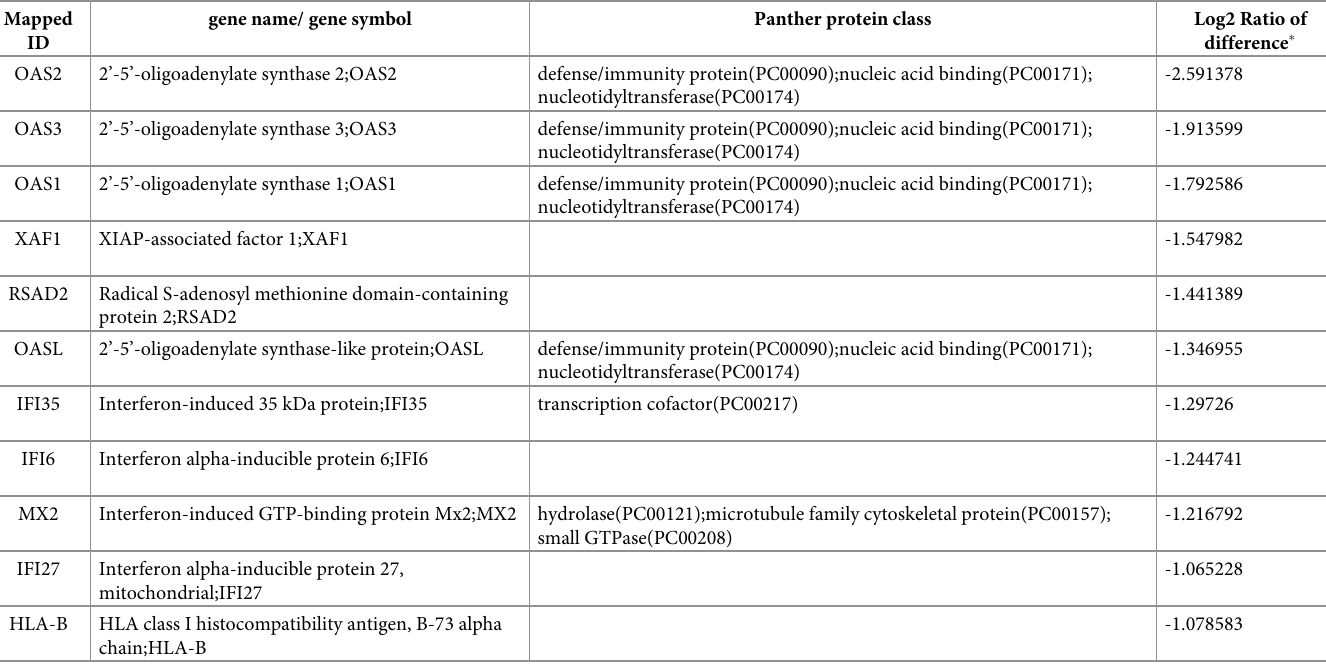
Table 1. Cellular genes belonging to type 1 interferon pathway are downregulated when IFITs are depleted. Mapped ID